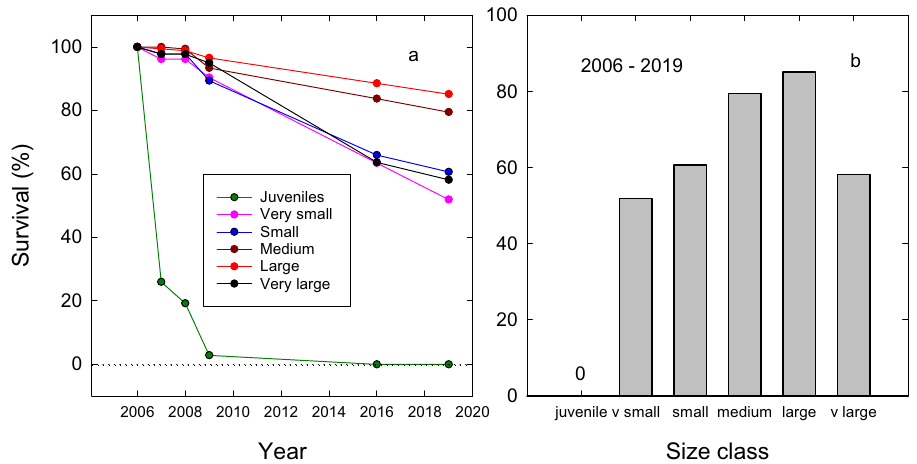
Figure 4. Percentage survival of the various size classes of Callitris intratropica at the Dukaladjarranj Aboriginal estate in central Arnhem Land: juveniles < 1.5 m tall (n = 385); very small trees > = 1.5 m tall and < 5 cm diameter at 1 m (D 1.0 , n = 52); small trees 5–10 cm D 1.0 (n = 94); medium trees are 10–20 cm D 1.0 (n = 166); large trees 20–30 cm